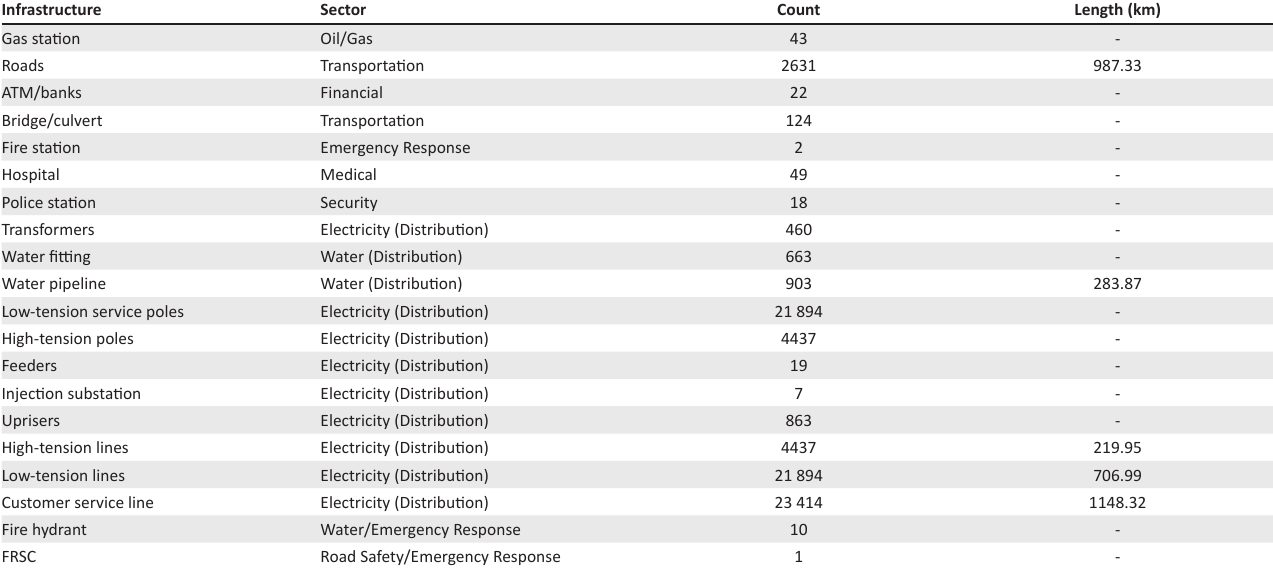
TABLE 1: Description of the relations in the